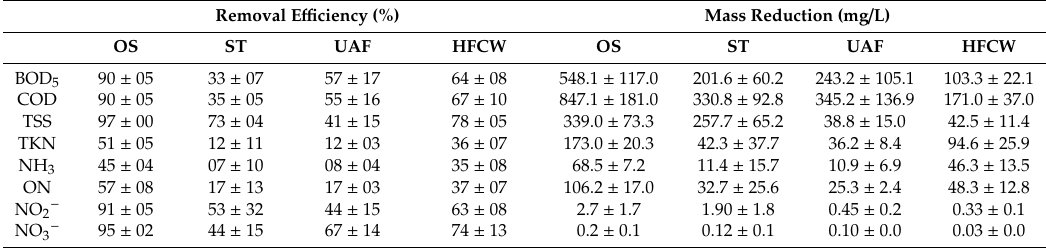
Table 2. Average values of removal e ffi ciency and mass reduction by step and for the complete